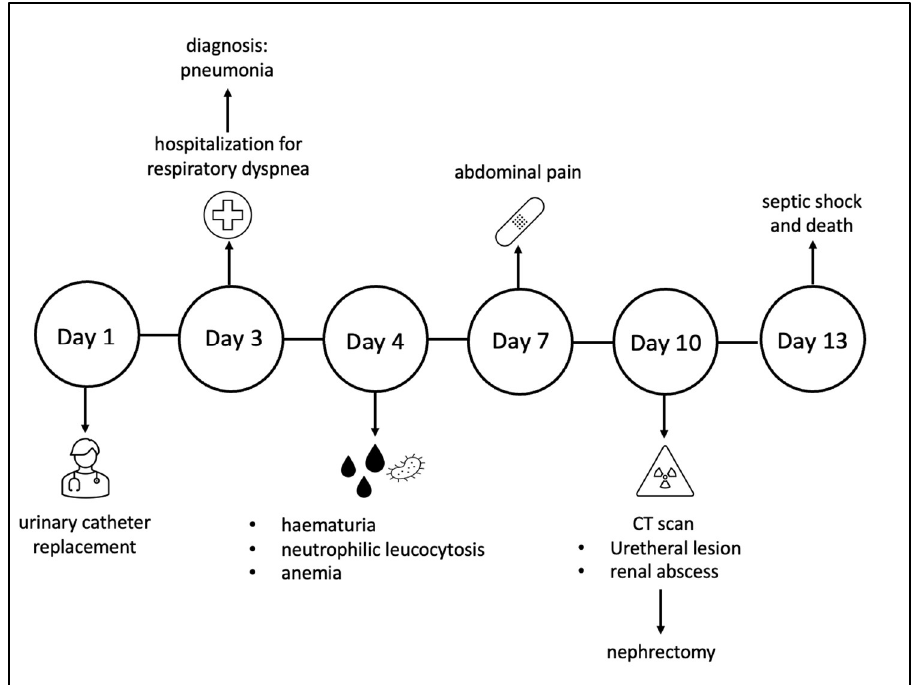
Figure 1. The timeline of this